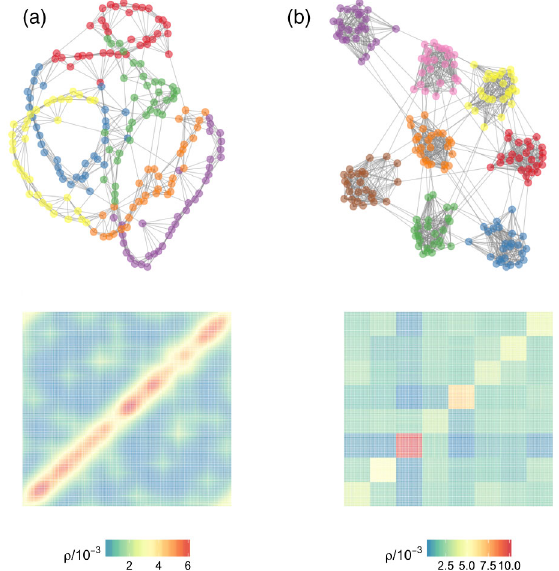
FIG. 1. Density matrix of a complex network. Network (top) and corresponding density matrix (bottom) from (a) a stochastic block model and (b) Watts-Strogats networks, for β ¼ 3 . 16 . Colors in the networks indicate nodes belonging to the same community, whereas colors in the density matrices indicate the magnitude of the corresponding entry. Networks with N ¼ 200 nodes are